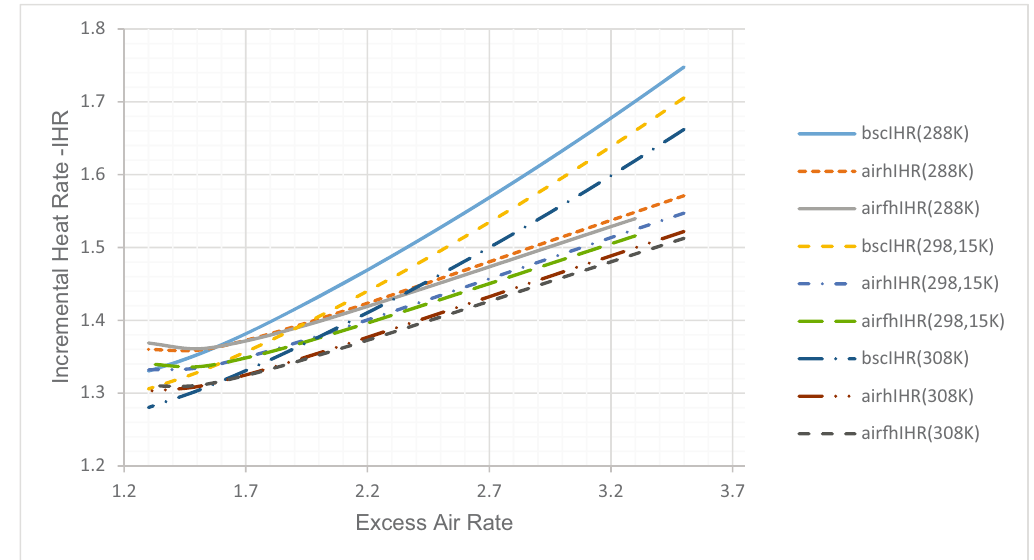
Figure 14: Variation of incremental heat rate with excess air coe ffi cient at di ff erent compressor inlet air temperatures for basic ( bsc ) , absorption cooling ( ab ) , air ( airh ) , and air fuel ( airfh ) heating cogeneration cycles ( m fuel = 1.64 kg/h, η isC = η isT = 0.86, r = 10, T recout = 850 K, T = 485.57 K, and T = 426 K ) . steam Exh